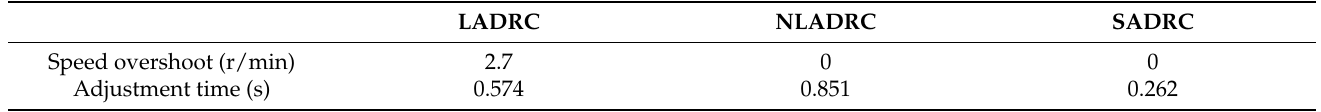
Figure 9. Speed step experiment from 20 r/min to 120 r/min: ( a ) LADRC ( b ) NLADRC ( c ) SADRC. Table 2. Performance comparison of speed step